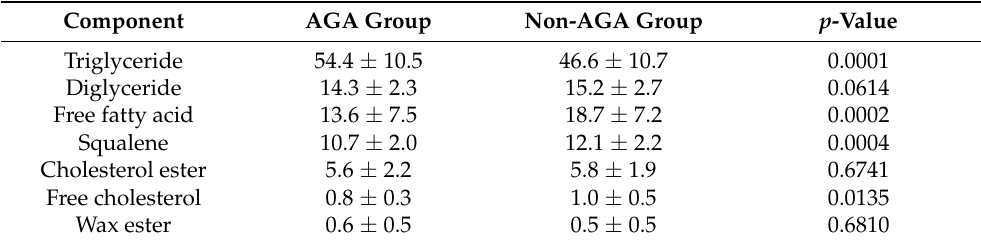
Table 1. Composition (%) of sebum from the scalps of the androgenetic alopecia (AGA) and non- AGA